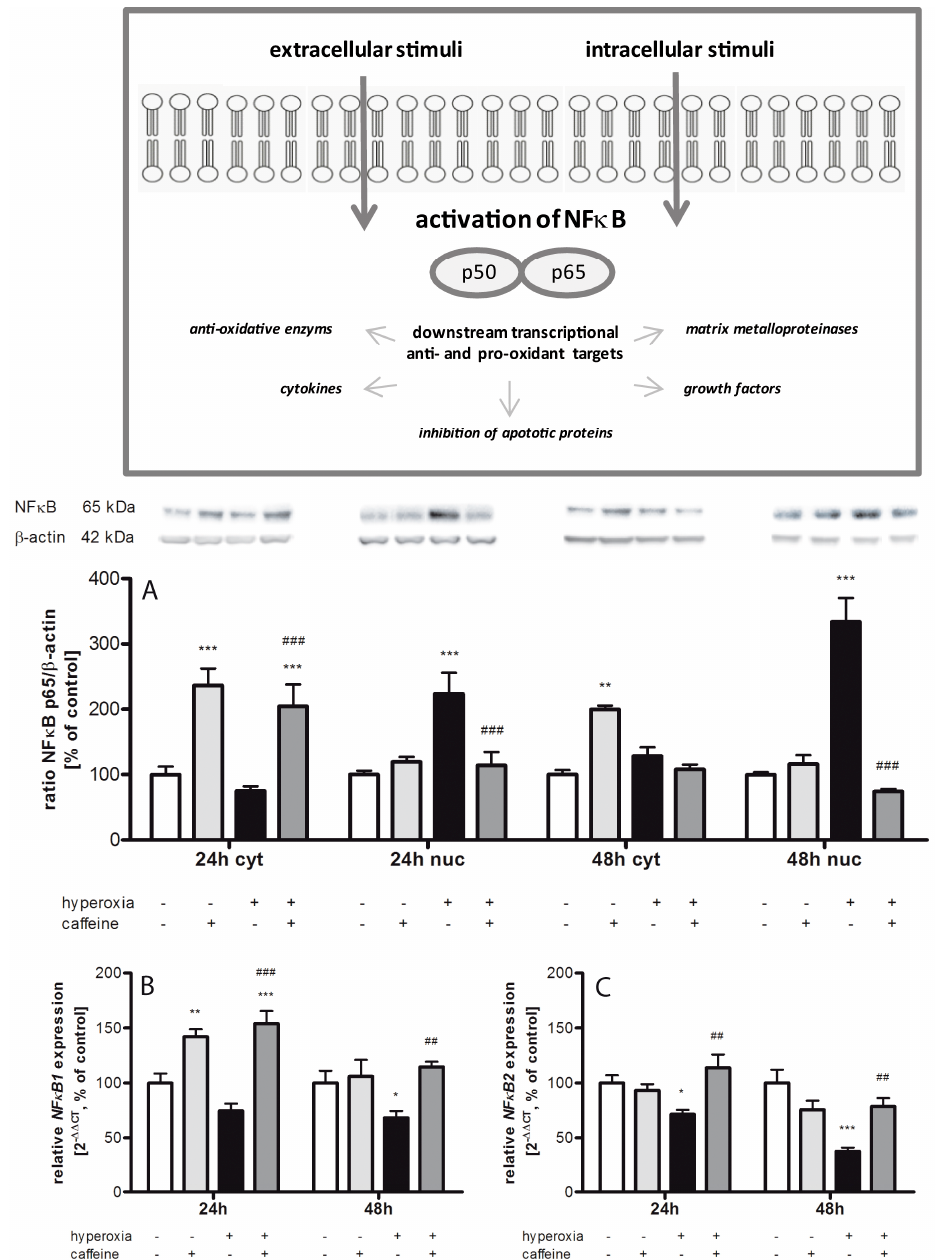
Figure 4. NF κ B expression is affected by caffeine administration. ( Box ) Stimulation of the NF κ B pathway is mediated by diverse signal transduction cascades. The change of protein expression of NF κ B were measured in brain homogenates of normoxia ( white bars ), caffeine with normoxia ( light grey bars ), hyperoxia ( black bars ), and hyperoxia with caffeine (dark grey bars) by Western blot and quantitative real-time PCR with: ( A ) NF κ B protein expression in cytosolic (cyt) and nuclear (nuc) fraction; and ( B , C ) NF κ B mRNA expression after 24 h and 48 h of oxygen exposure. Data are shown as mean ± SEM, n = 5 per group per time point. The 100% value is: ( A ) (cyt) 0.035 and 0.024 ratio intensity/mm 2 and (nuc) 0.092 and 0.127 ratio intensity/mm 2 ; ( B ) 1.017 and 1.028 C T ; and ( C ) 1.010 and 1.032 C T for 24 and 48 h groups, respectively. Data were analyzed by two-way ANOVA with Bonferroni post hoc test, with * p < 0.05, ** p < 0.01, and *** p < 0.001 versus control (atmospheric air), and ## p < 0.01 and ### p < 0.001 versus hyperoxia (80% oxygen without caffeine).